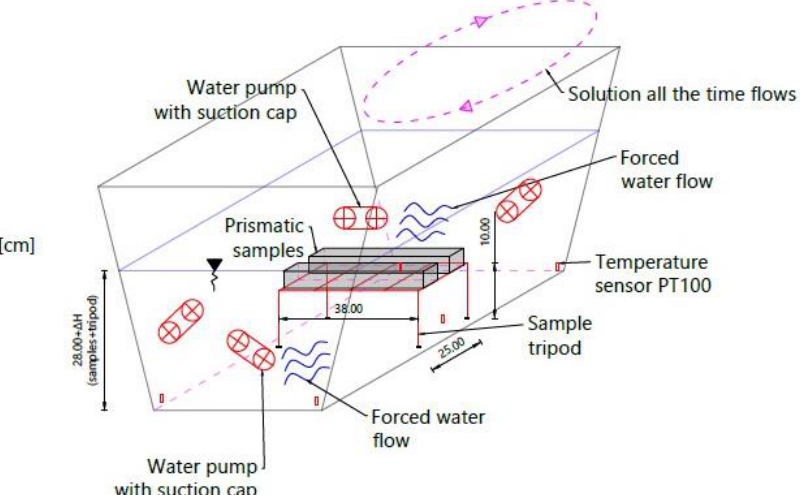
Figure 3. Experimental brine soaking pattern.